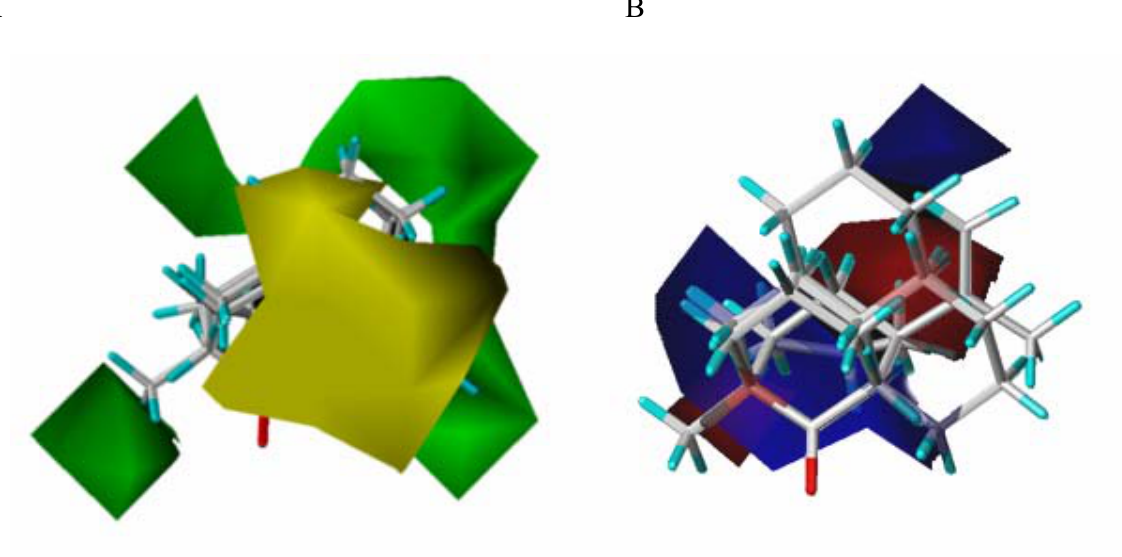
Figure 6. Steric hindrance (green-yellow, Figure A) and electrostatic (red-blue, Figure B) zones. CoMFA models of the reduction biocatalyst. Steric hindrance zones: Green areas depict zones of space where occupancy by the substrates increases affinity, whereas yellow areas depict zones where occupancy decreases affinity. Electrostatic zones: areas where a high electron density provided by the ligand increases (red) or decreases (blue) the activity.